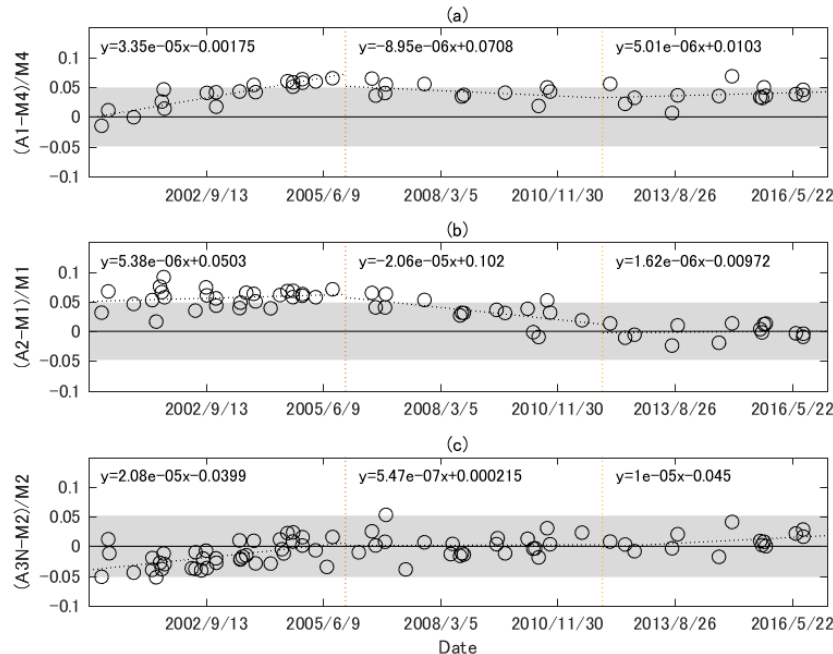
Figure 4. Relative differences between spatially aggregated ASTER radiances for bands 1, 2, and 3N and spectrally adjusted MODIS radiances for bands 4, 1, and 2: ( a ) ASTER band 1 and MODIS band 4; ( b ) ASTER band 2 and MODIS band 1; ( c ) ASTER band 3N and MODIS band 2. The shaded areas indicate the range inside the estimated uncertainty in ASTER-MODIS cross-calibration using calibrated ASTER and MODIS data.